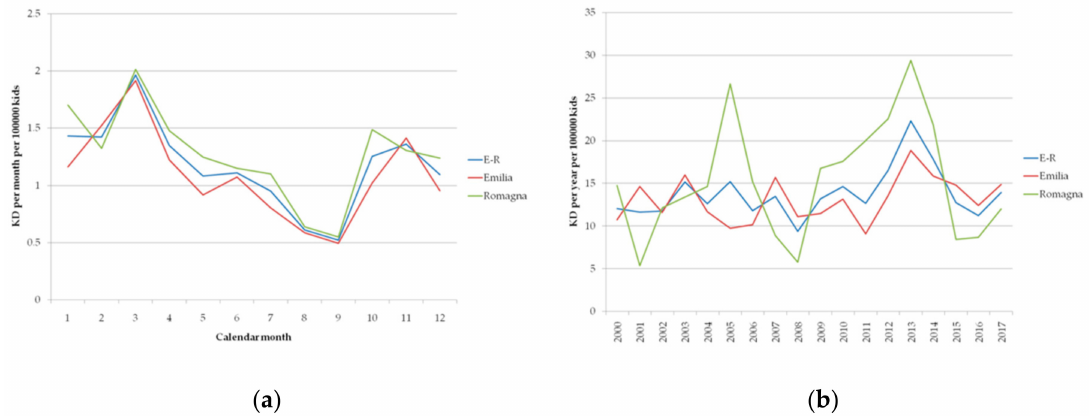
Figure 3. Number of cases per 100,000 kids of reported KD onset in children under 5 years old over the period 2000–2017 ( a ) mean value over the period as a function of calendar month and ( b ) total value as a function of the year in Emilia-Romagna (blue curve) in Emilia (red curve) and in Romagna (green